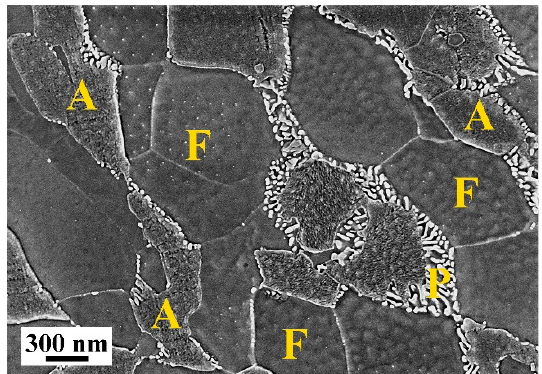
Figure 16. SEM micrograph showing the formation of pearlite phase in a specimen tested to fracture at 400 °C. F: ferrite, A: austenite, P: pearlite.